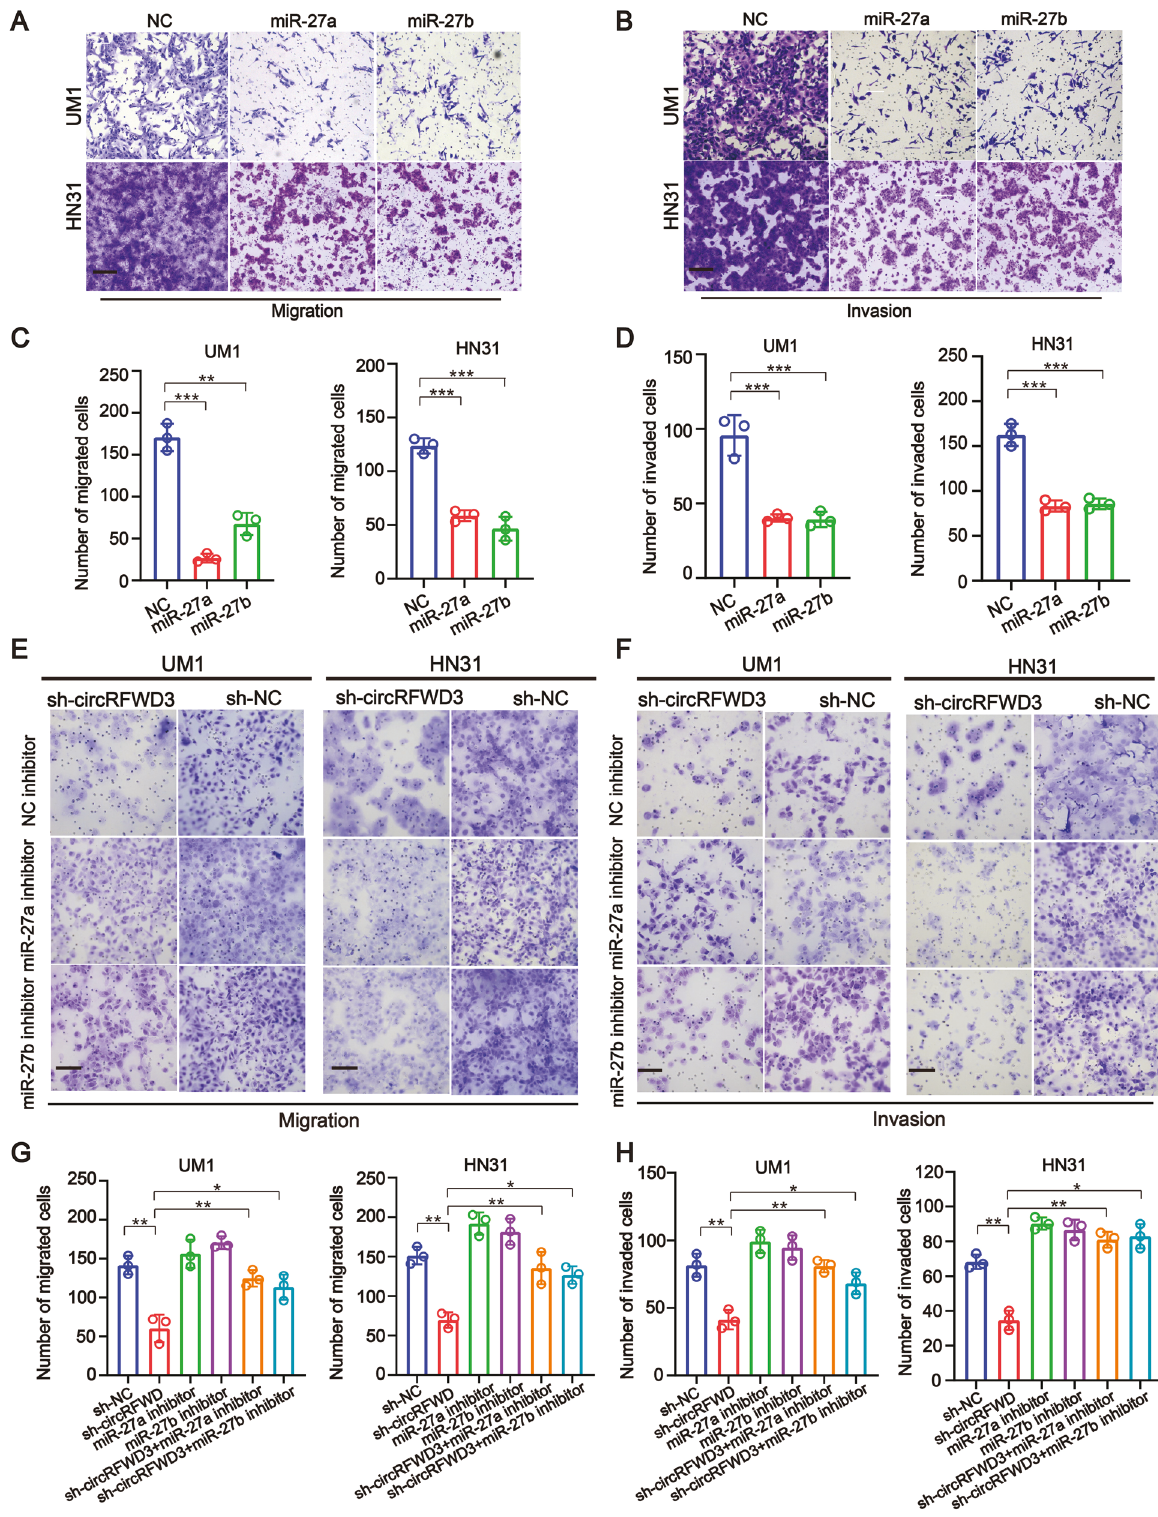
Fig. 4 Both miR-27a and miR-27b could reverse the tumor metastasizing-effects of circRFWD3 in HNSCC cells. A , C Transwell assays indicated that the migration ability of UM1 and HN31 cell were observably restricted by transfection of miR-27a and miR-27b mimics. B , D Transwell assays indicated that the invasive capabilities of UM1 and HN31 cell were observably restricted by transfection of miR-27a and miR-27b mimics. E – H Transwell assays revealed that miR-27a and miR-27b inhibitors could rescue the inhibitory effects of circRFWD3 knockdown of migration and invasion in UM1 and HN31 cells. Scale bar, 100 μ m. data were shown as the mean value ± SD of three independent experiments. The asterisks indicate signi fi cant differences (Student ’ s t -tests, * P < 0.05, ** P < 0.01, *** P < 0.001).